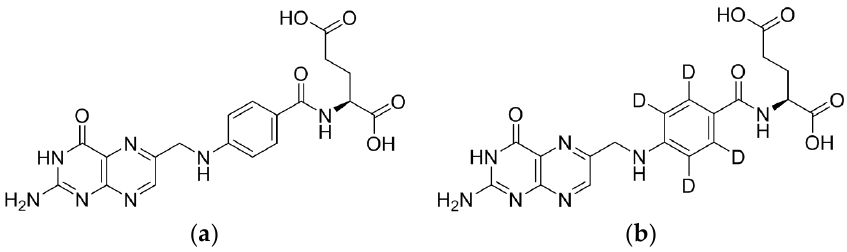
Figure 1. Structures of ( a ) folic acid and ( b ) folic acid-d4 (internal standard).